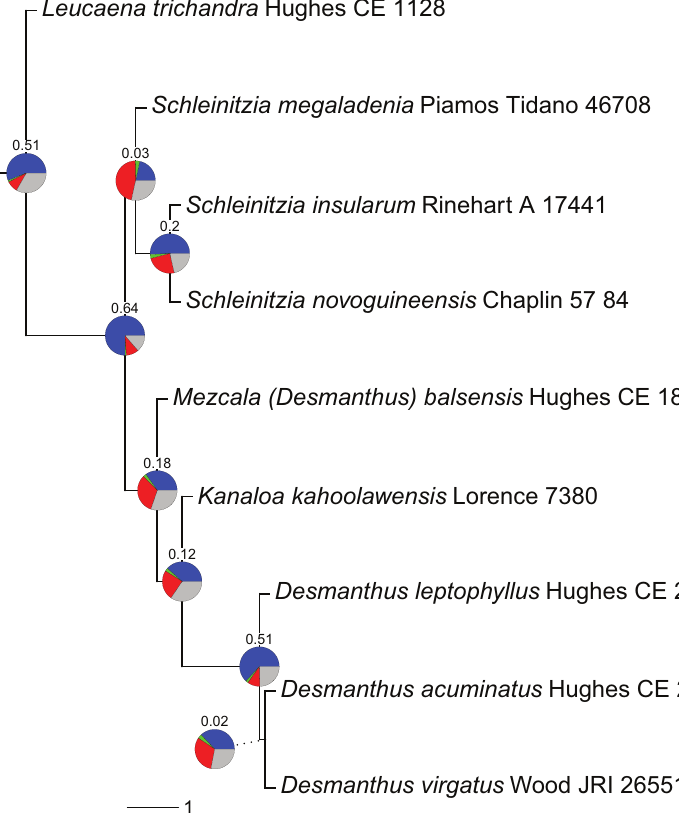
Figure 1. Phylogeny showing sister group relationships of the genera of the informal Leucaena group based on analysis of 997 nuclear gene sequences. The root of the phylogeny is indicated with an arbitrary branch length. Pie charts show the fraction of gene trees supporting that bipartition in blue, the fraction of gene trees supporting the most likely alternative configuration in green, the fraction of gene trees sup- porting additional conflicting configurations in red, and the fraction of uninformative gene trees in grey. Numbers above pie charts are Extended Quadripartition Internode Certainty scores. Branch lengths are expressed in coalescent units, and terminal branches were assigned an arbitrary uniform length for visual clarity, see Ringelberg et al.